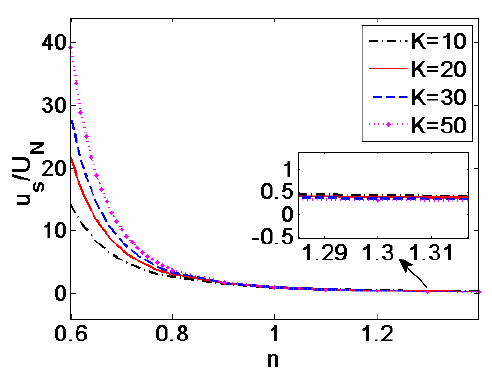
Figure 4. Variation of the average velocities generalized by the average velocity of Newtonian fluid ( n = 1) with flow behavior index n at different dimensionless electrokinetic width K ( ζ = − 0.1 V).